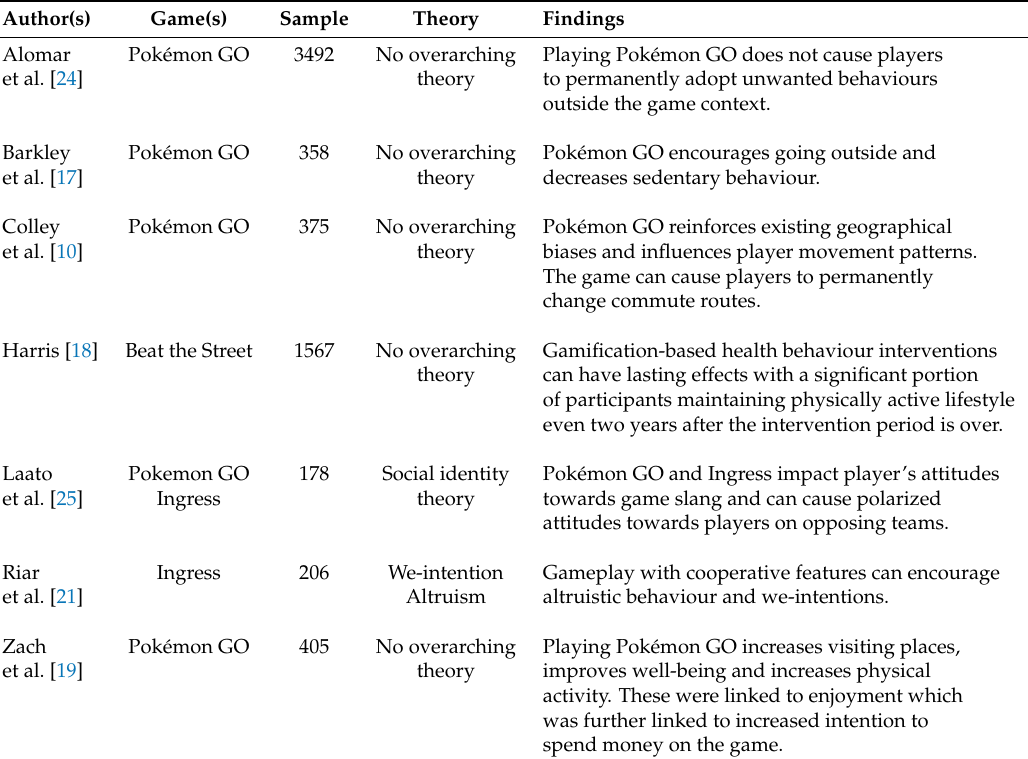
Table 1. Summary of the extant literature on how location-based games influence